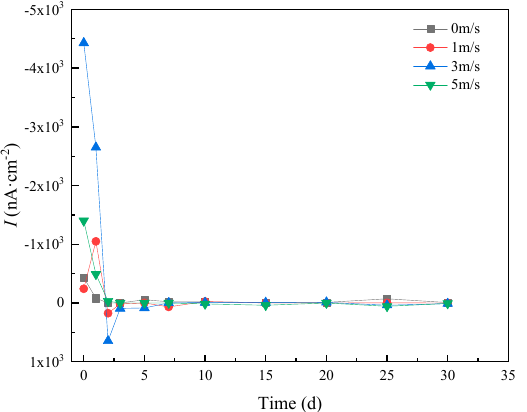
Figure 13. Variation of galvanic current between HAZ and WZ with time and flowing rate .